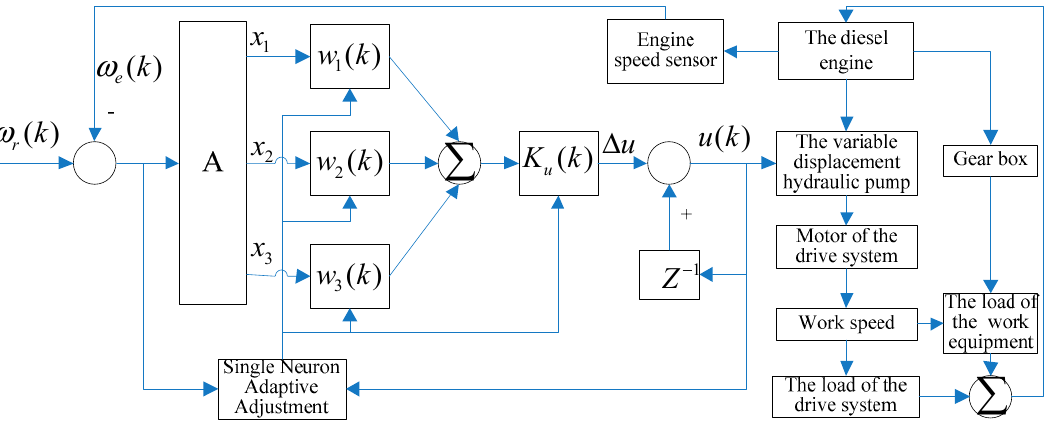
Figure 4. Structure of the adaptive power control of a cold milling machine.